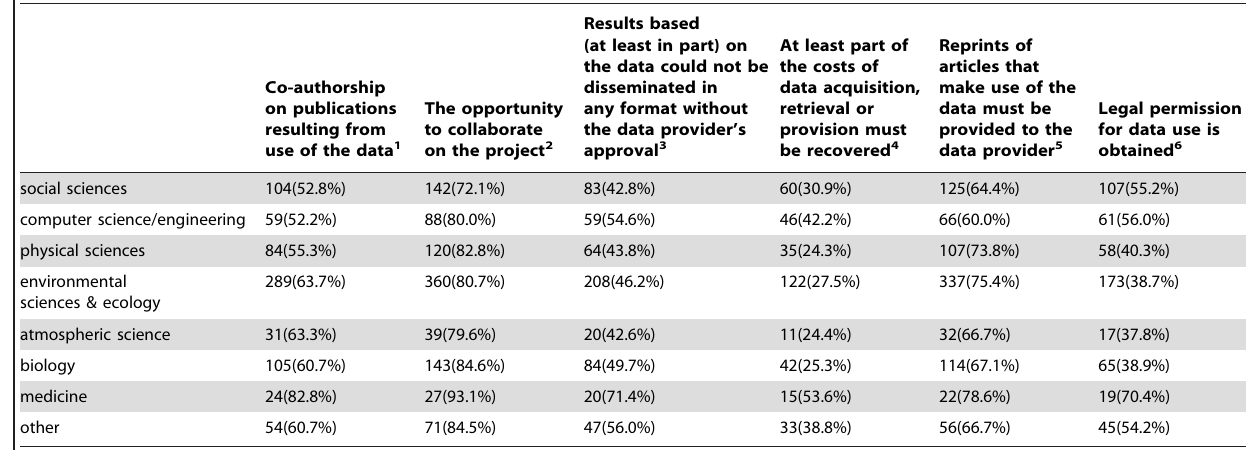
Table 21. Using others’ data by subject discipline.